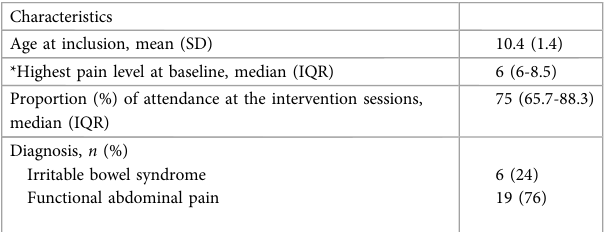
TABLE 1 Characteristics of the sample ( n